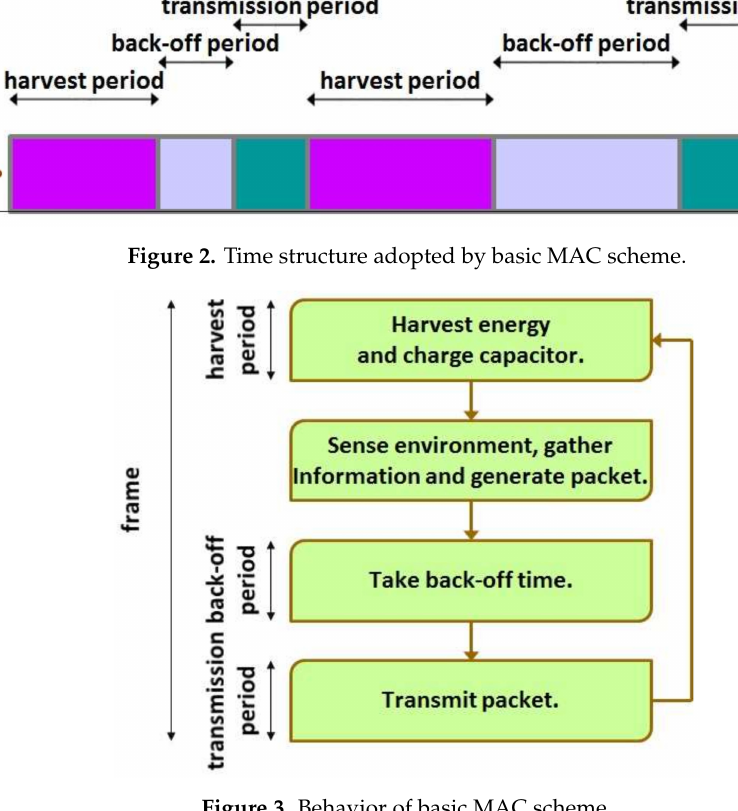
Figure 3. Behavior of basic MAC